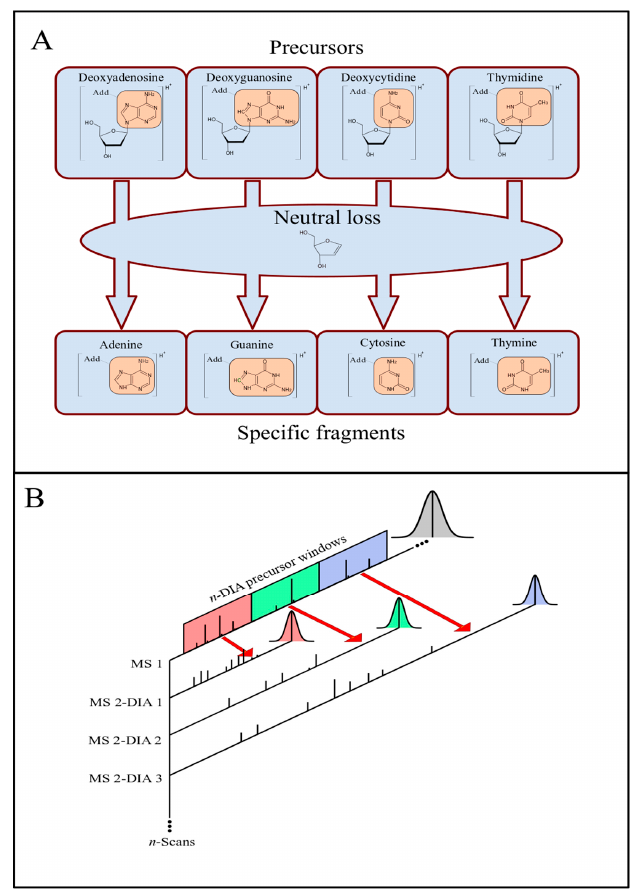
Figure 1. Analysis of DNA adducts by LC-MS/MS with the data-independent acquisition (DIA) method. ( A ) Fragmentation: nucleoside adducts (modification represented as “Add”) and respective CID tandem MS products as nucleobase adducts, with a deoxyribose neutral loss. ( B ) DIA method: precursor ion scans (MS1) are followed by sequential CID product ions scans within specific precursor m / z windows. The scan sequence is repeated throughout the LC elution process.